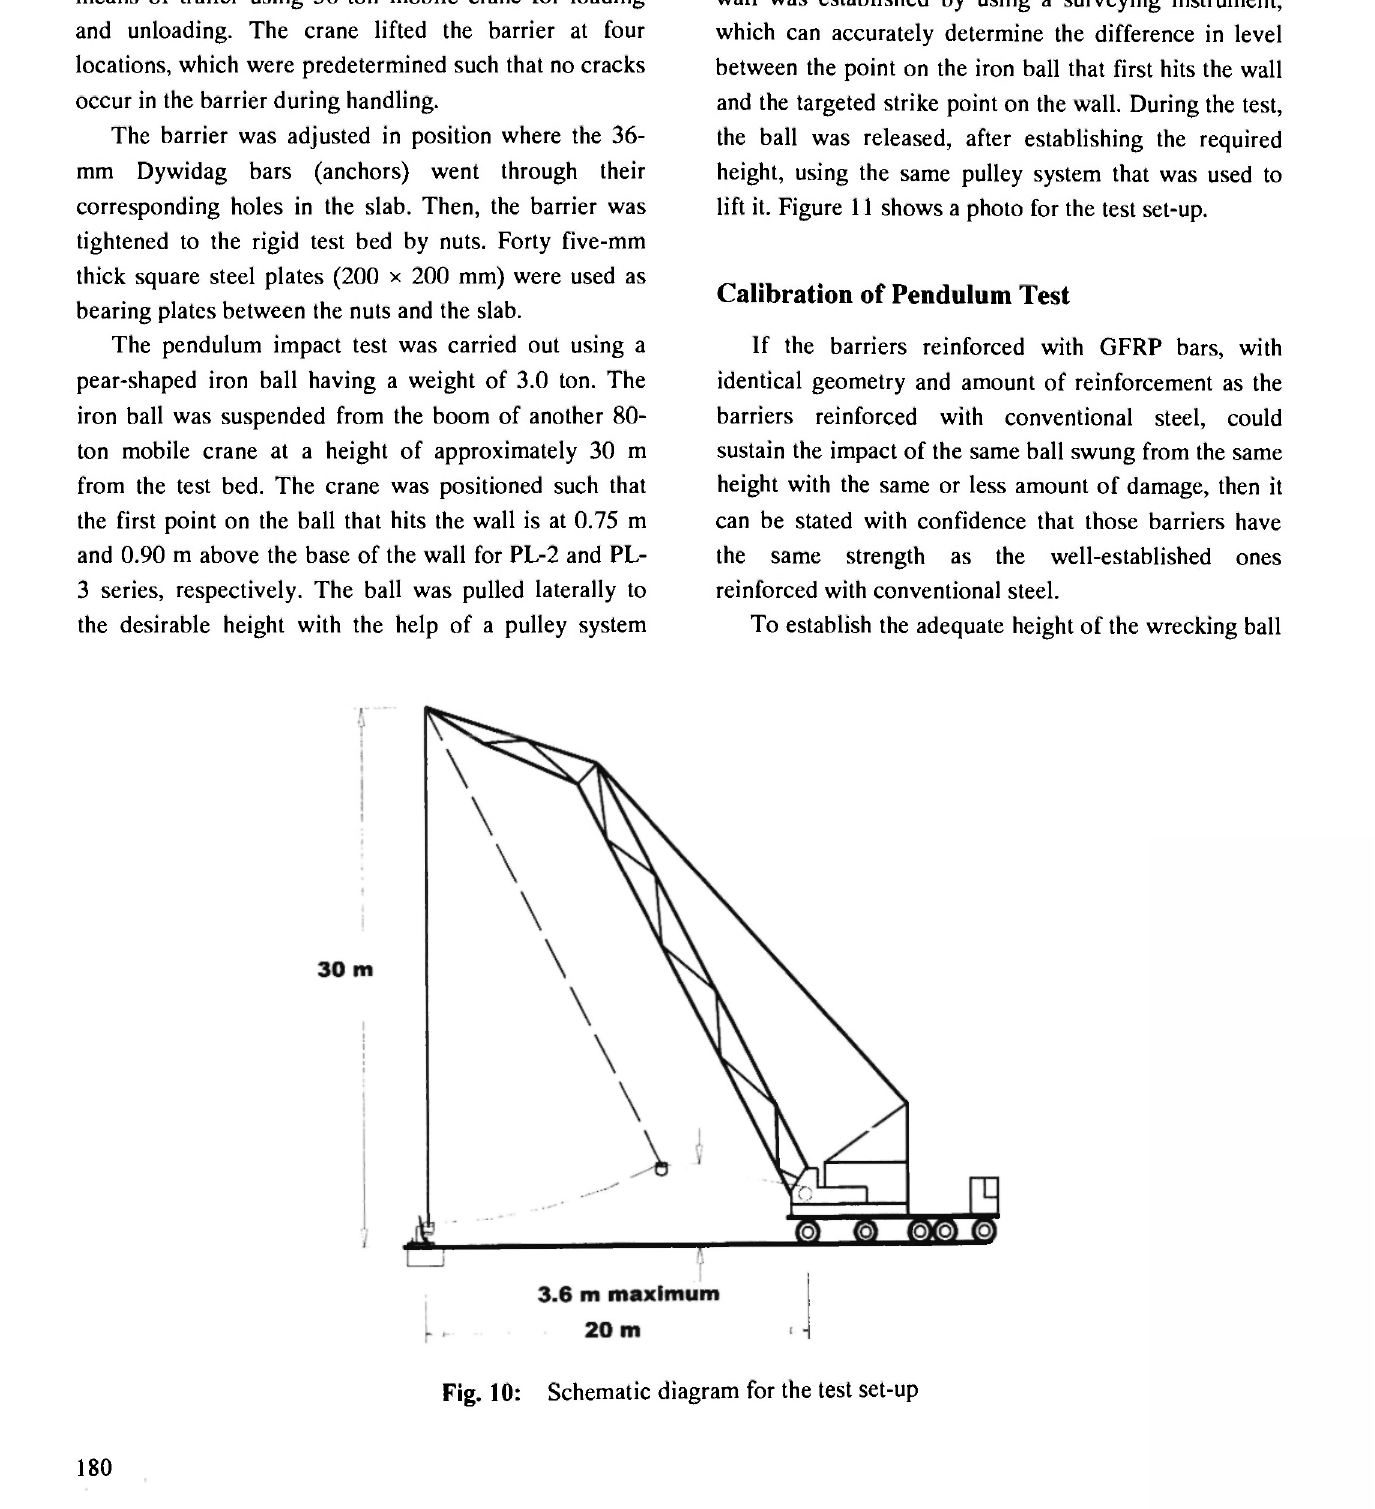
Fig. 10: Schematic diagram for the test